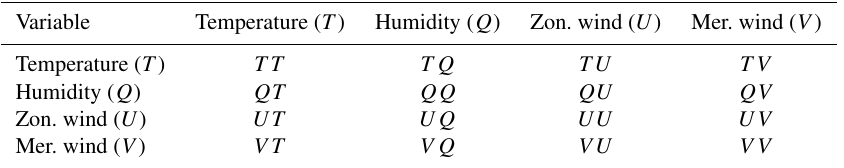
Table 1. Analyzed correlation pairs. Self-correlations on the diagonal and cross-correlations on the off-diagonal of the table. The first variable of each pair represents the ensemble at the reference